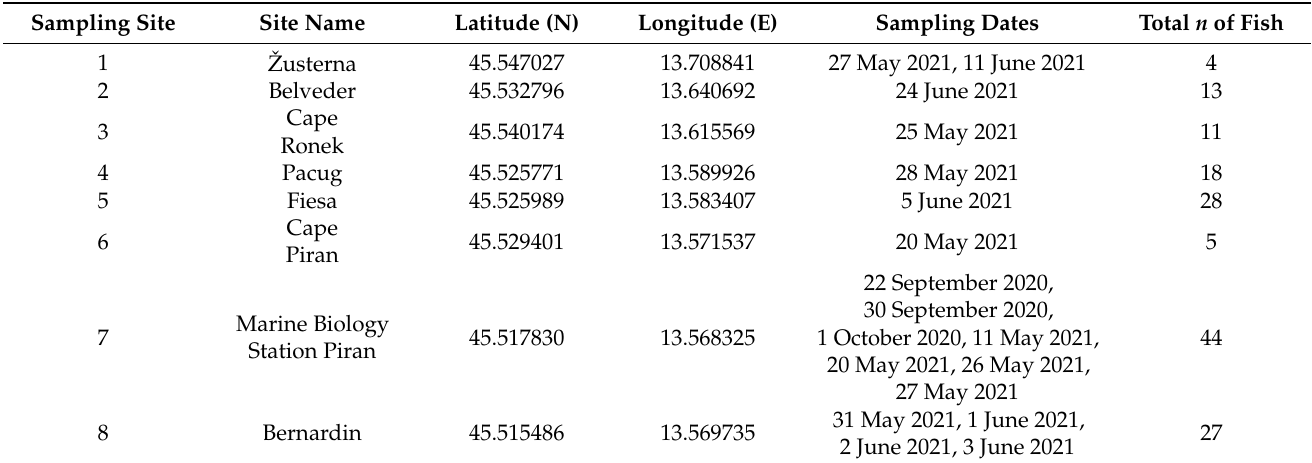
Table 1. Coordinates of the sampling sites for S. scriba in Slovenian coastal waters, sampling dates and number of fish